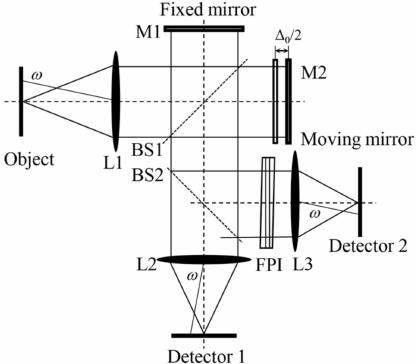
Figure 5. Improved MJI-HI optical system